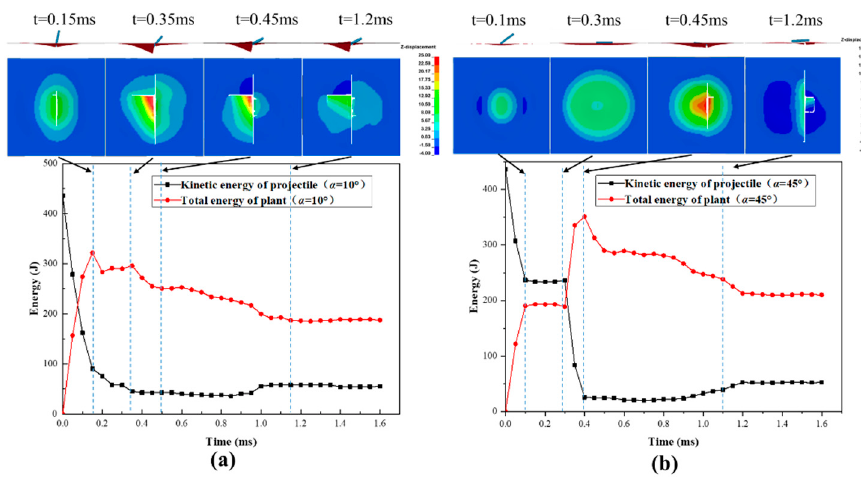
Figure 8. Energy evolution process and impact damage process for Laminate45 under impact V cr,n = 115 m/s with two different projectile deflection angles of α = 10° ( a ) and α = 45° ( b ).